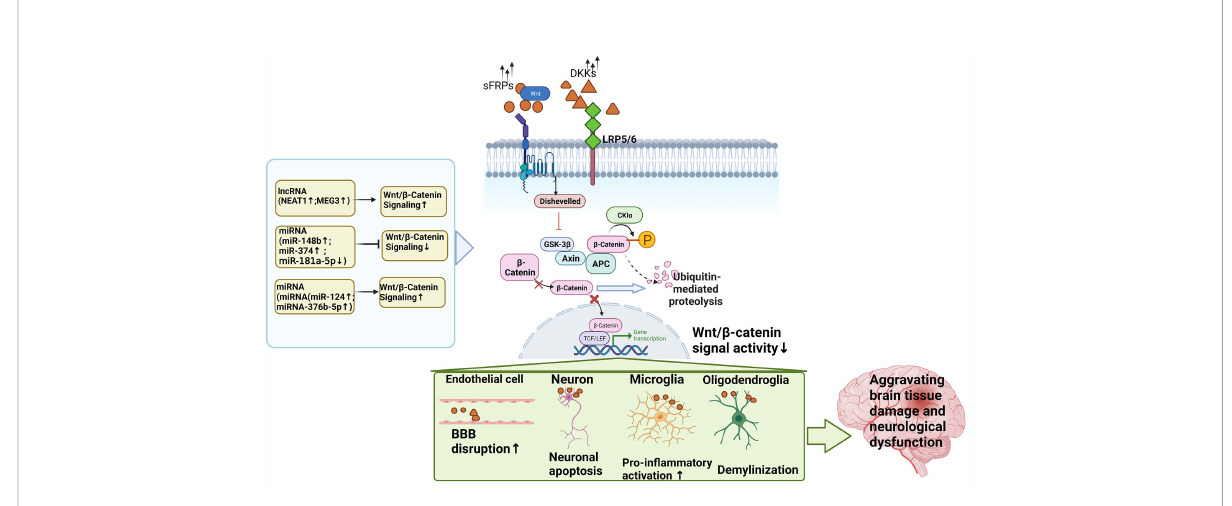
FIGURE 4 The action mode of ncRNAs in the Wnt signaling pathway.